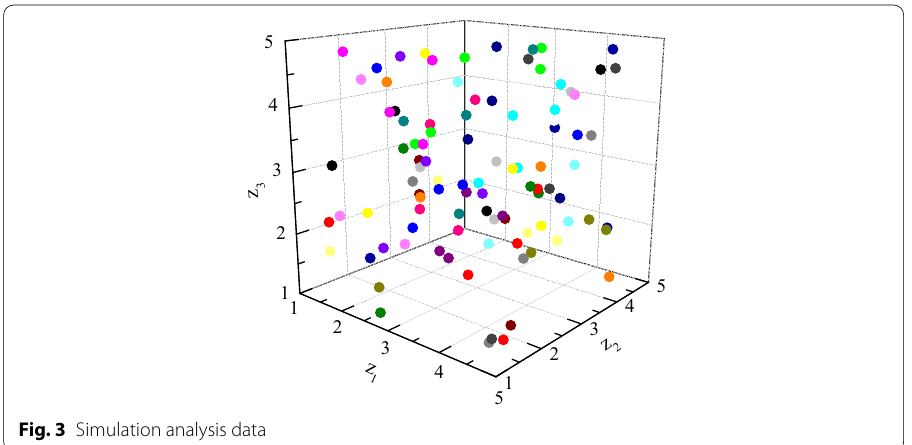
Fig. 3 Simulation analysis